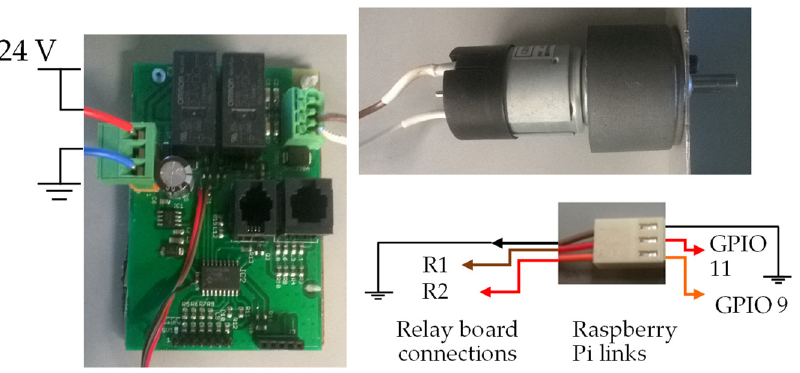
Figure 24. Image showing the connections between the document height adjustment and the control board, as well as the connections to the